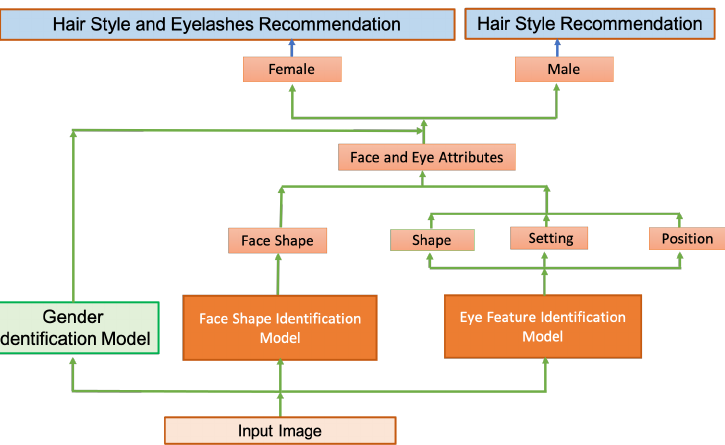
Figure 5. Block diagram of proposed method including three models: face shape identification model, eye feature identification model, gender identification